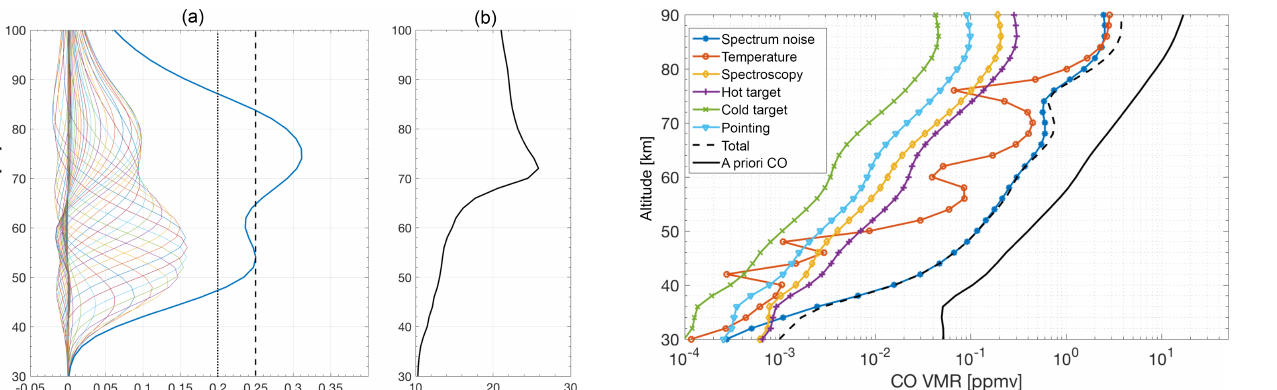
Figure 4. The mean averaging kernels for the CORAM inversions. The measurement response (sum of the rows of the averaging ker- nels) divided by 4 is shown by the thick solid blue line. The dashed black line and the dotted black line indicate a measurement response of 1.0 and 0.8, respectively. (b) The mean altitude resolution of the CORAM CO profiles, calculated from the FWHM of the averaging kernels.